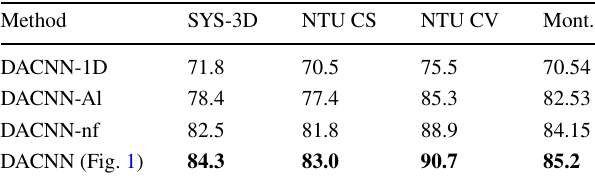
Table 5 Ablation study: prediction accuracies (%) for partial imple- mentations of DACNN on three selected datasets Method SYS-3D NTU